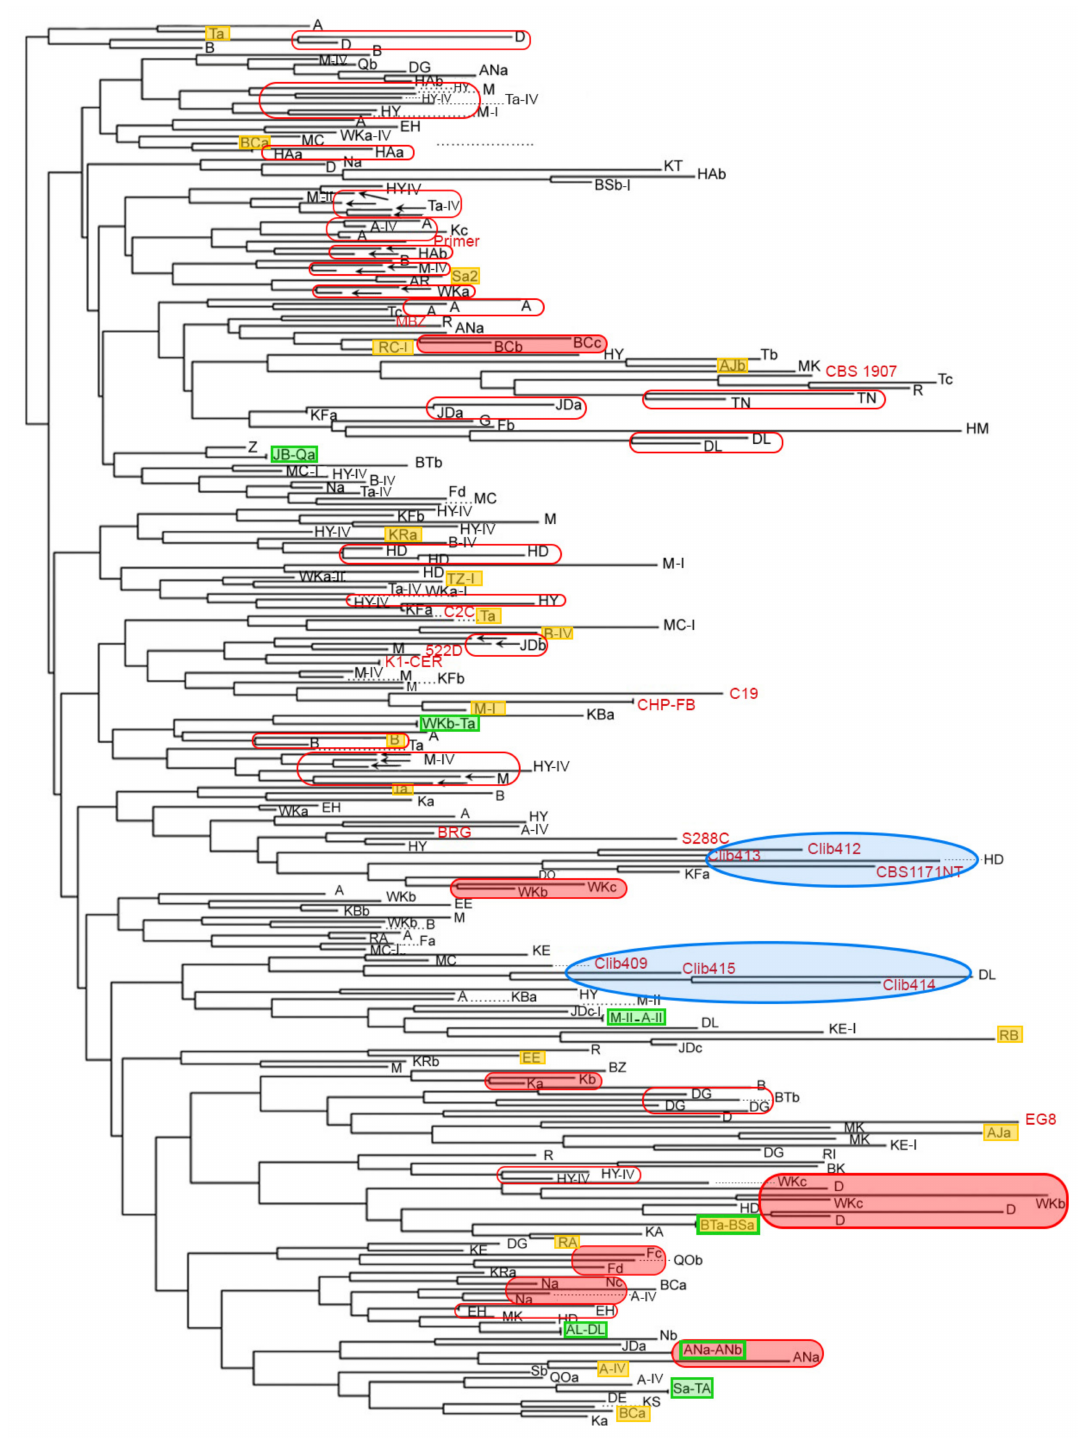
Figure 1. Clustering of 233 Lebanese and 19 non-Lebanese isolates according to interdelta fingerprinting. Lebanese isolates are indicated by the initials of their corresponding wineries. Redundant isolates from the same vats or wineries are not represented. Wineries names are indicated by capital letters representing the initials of the village (e.g., HA). When several wineries are examined per village, uppercase letters are followed by lowercase letters (e.g., HAa, HAb). Most of the isolates were sampled in year III unless otherwise indicated by I, II or IV at the end of the isolate name. Non-Lebanese isolates are in red. Red non-filled and red-filled rectangles correspond respectively to highly similar isolates from the same winery, or from wineries of the same village. Yellow and green filled rectangles correspond respectively to isolates taken from sweet wines or identical isolates from different wineries. Blue ovals highlight two clusters of non-oenological